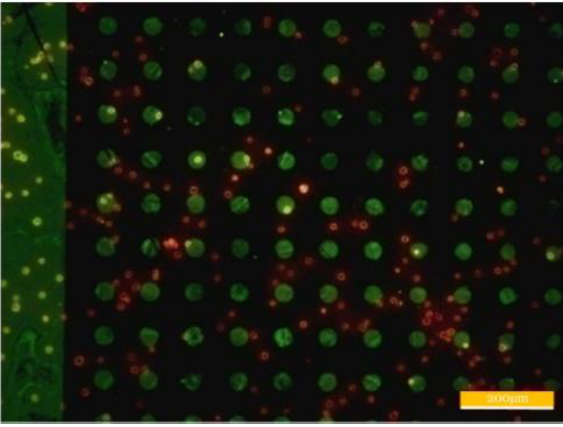
Figure 9. Patterning results of CD15 antibodies and HL-60 cells.